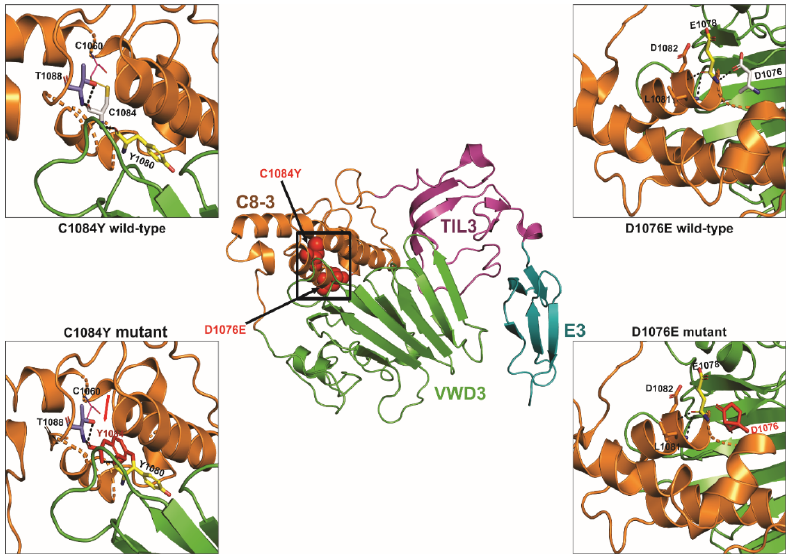
Figure 5. Ribbon diagrams highlighting p.Cys1084Tyr and p.Asp1076Glu mutations in the D3 domain of VWF protein. The experimentally determined 3D protein structure of human VWF D3 domain is shown in the middle with modular domains highlighted as vWD3 (green), C8-3 (orange), TIL3 (magenta), and E3 (cyan). The black open square locates the p.C1084Y and p.D1076E mutations, both in the vWD3 domain. The inserts on the left depict the aberrant disulfide bonding as a result of p.C1084Y mutation, whereas the inserts on the right show changes in hydrogen bonding consequential of p.Y357H mutation. The amino acid residues involved in disulfide bonding and polar contacts are shown as stick models. Models were obtained with PyMol Molecular Graphics System and 6N29 file.